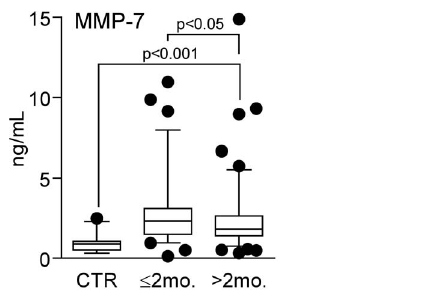
Figure 1. Plasma levels of MMP-7 in patients with carotid plaques in relation to symptomatology. The figure shows plasma levels of MMP-7 in patients with carotid atherosclerosis (n=182) divided into (i) patients with the most recent symptoms (within the last 2 months, n=73) and (ii) patients with symptoms . 2 months ago and asymptomatic patients ( . 2 months, n=109). For comparison, MMP-7 levels were also analyzed in 23 healthy controls (CTR). Data are shown as a box and whisker plot with median (Q1, Q3) in the box and the whiskers representing the 5 and 95 percentiles. Note that both groups of patients have significantly raised MMP-7 levels as compared with controls.